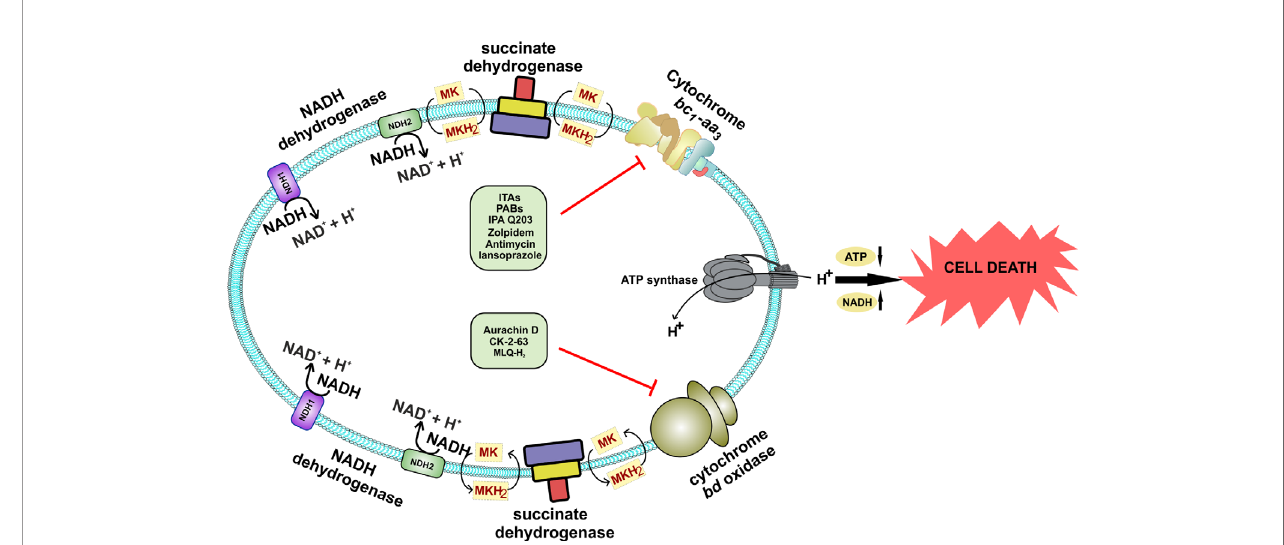
FIGURE 5 | Schematic representation of the effect of inhibition of both the terminal oxidases of Mycobacterium species. Inhibition of both the terminal oxidases leads to cell death. A combination of various drugs could directly target both of these terminal oxidases, which are speci fi c to Mycobacterium and could effectively kill the bacteria, thus providing a novel drug target against Mycobacterium